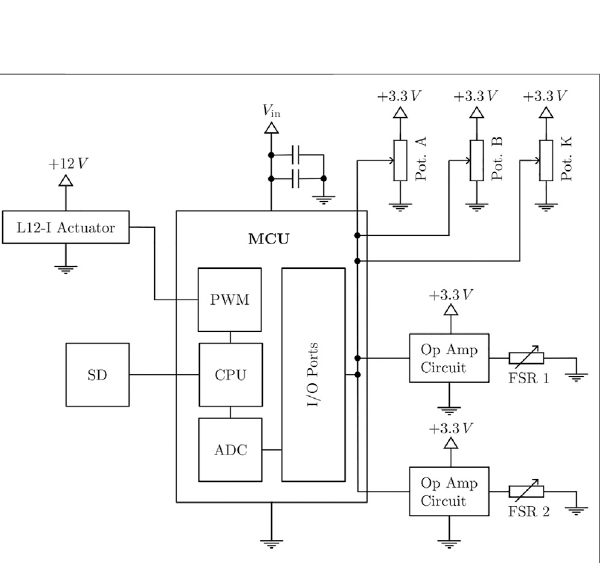
FIGURE 8 | Interconnection of all electric components of the exoskeleton